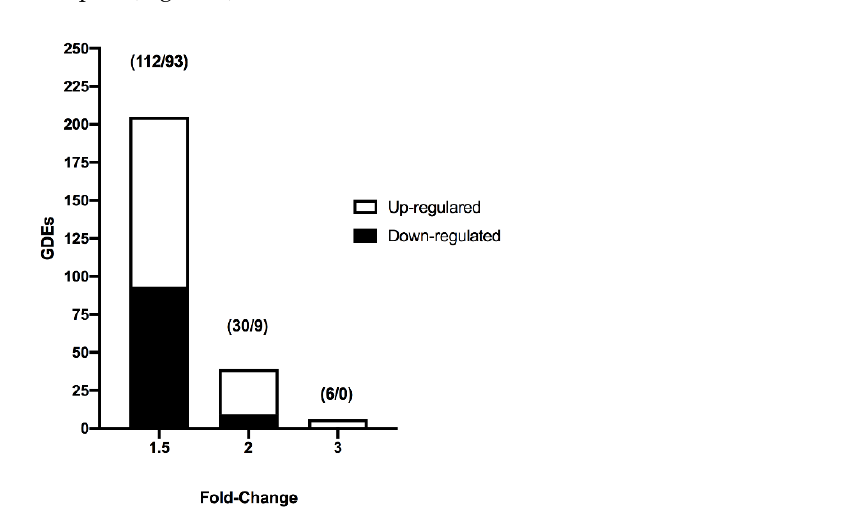
Figure 1. Number of differentially expressed genes (DEGs) identified from the transcriptome analysis of vitrified blastocysts using different fold change (1.5, 2, and 3) values and p -values < 0.05. Numbers within parentheses represent the number of upregulated and downregulated DEGs.